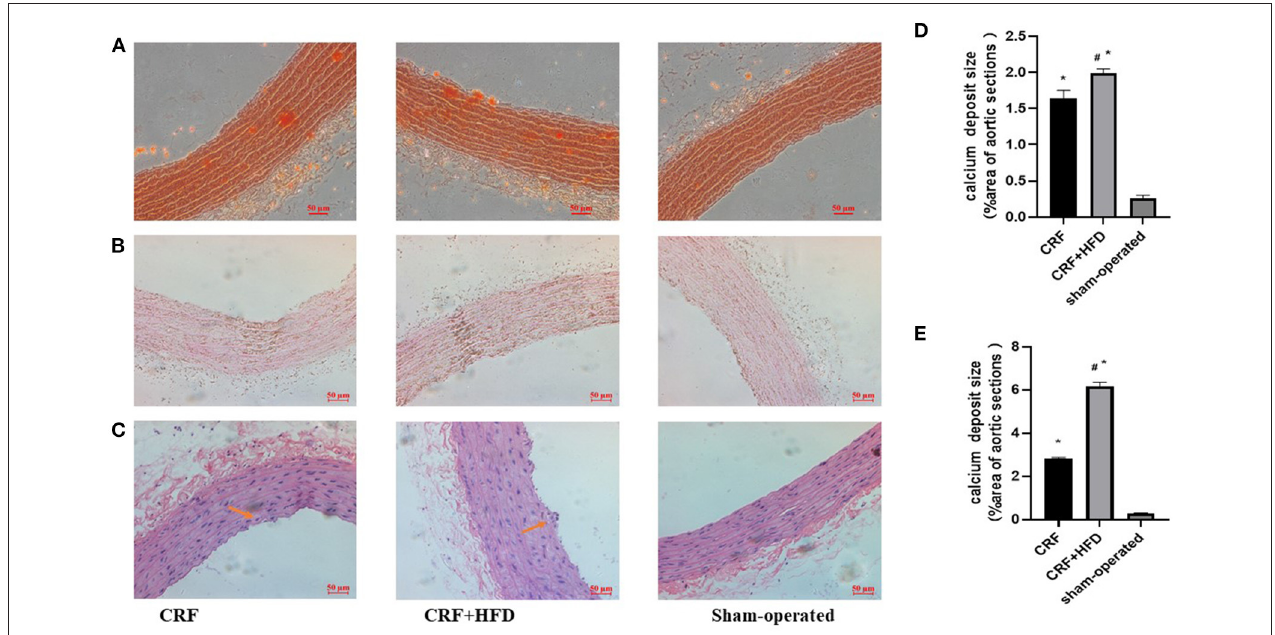
FIGURE 3 | Staining of rat aorta in each group. (A) Alizarin red staining of rat aorta in each group. (B) Von Kossa staining of rat aorta in each group. (C) staining of rat aorta in each group. (D) Quantification of calcium deposits in rat aortas stained with Alizarin Red. (E) Quantification of calcium deposits in rat aortas stained with Von Kossa. Six rats were included in each group. * P < 0.05 vs. sham-operated group; # P < 0.05 vs. CRF group. CRF, chronic renal failure; HFD, high fat